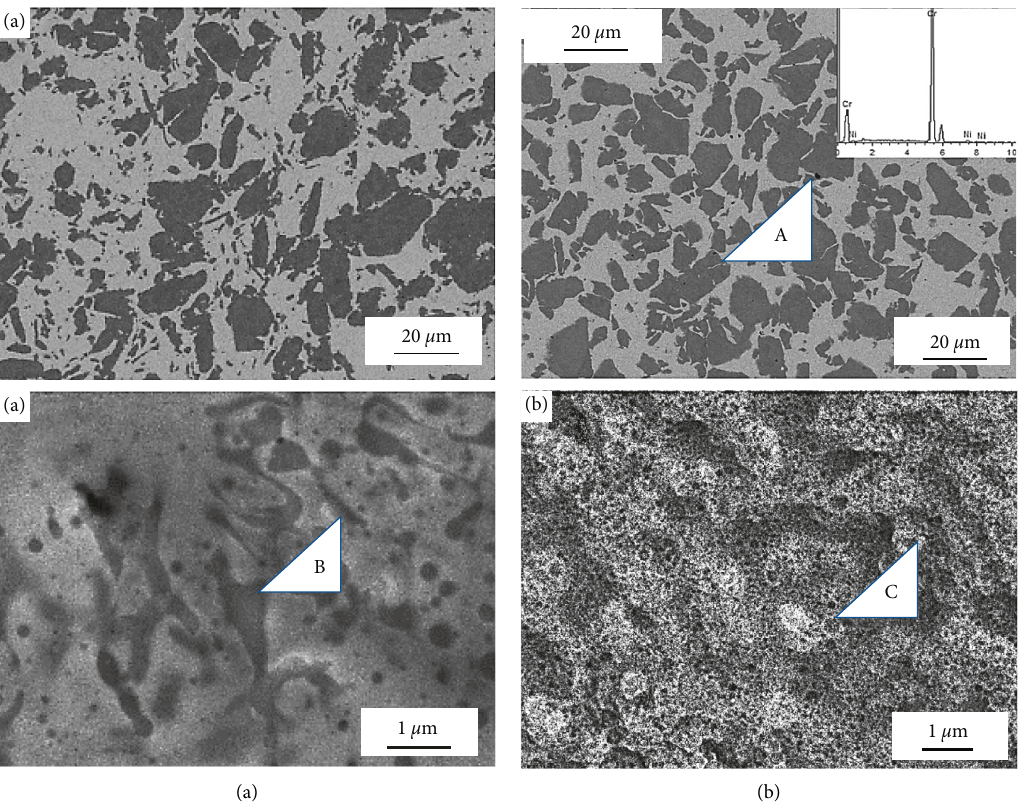
Figure 20: Microstructures of the Cu-Cr-Ni alloys and after the vacuum breakdowns (Cu � 55, Cr-Ni � 45, at.%) alloys: (a) Cu55Cr45. (b) Cu55(Cr95Ni5)45 [19].